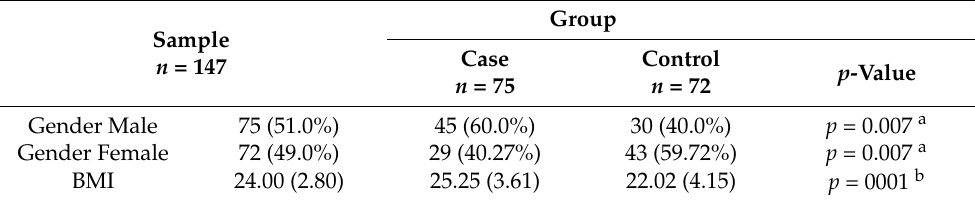
Table 1. Whole sample demographic values of the demographic variables for both groups (average ± standard deviation) are shown.